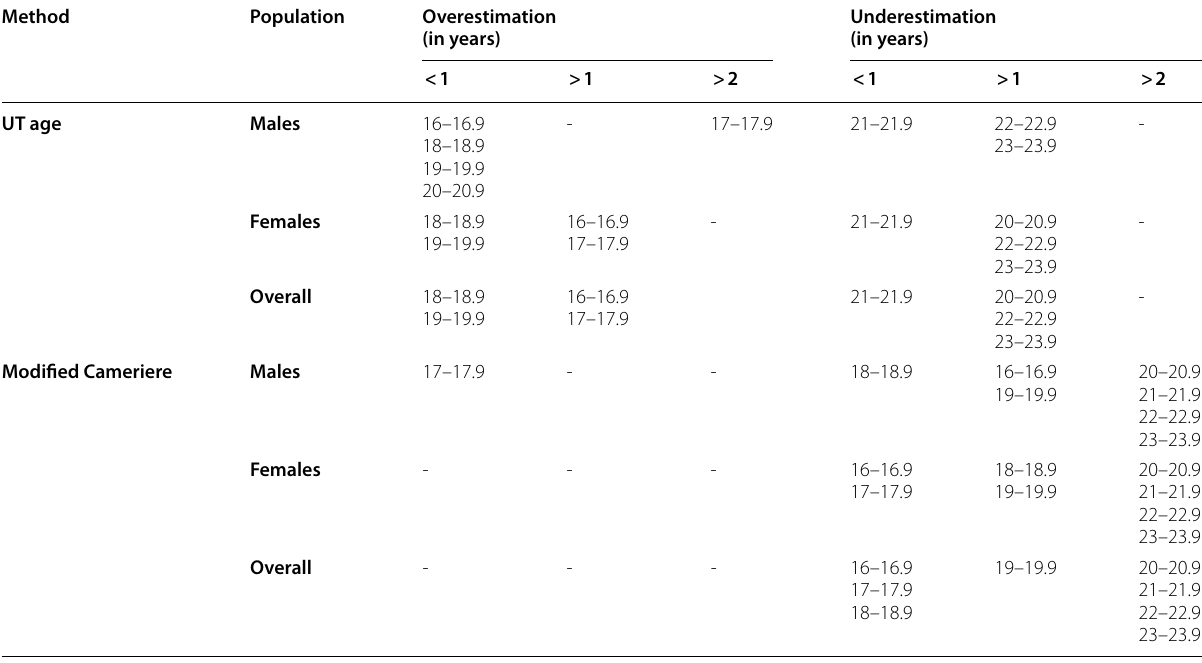
Table 3 Overestimation and underestimating of chronological age calculated using the modified Cameriere’s approach and the UT-age estimation method in terms of less than a year, more than a year, and 2 years